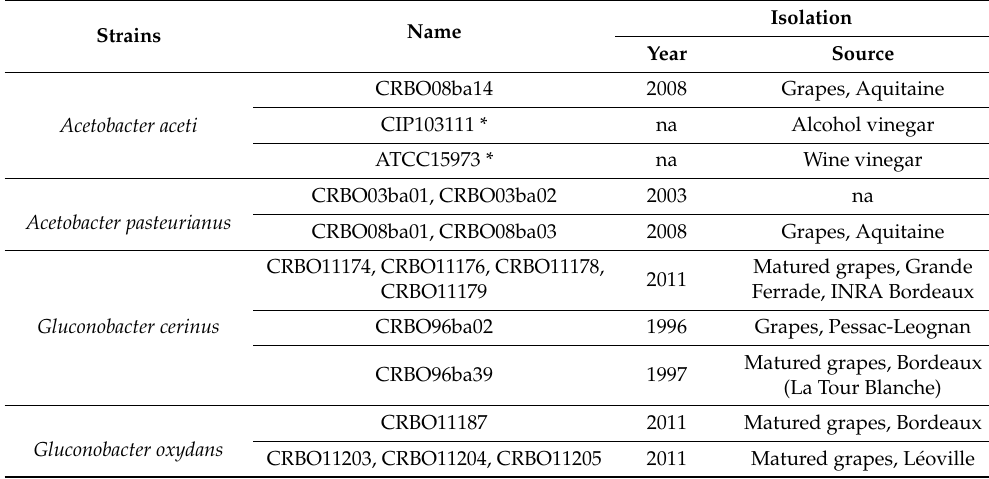
Table 1. Strains used in the